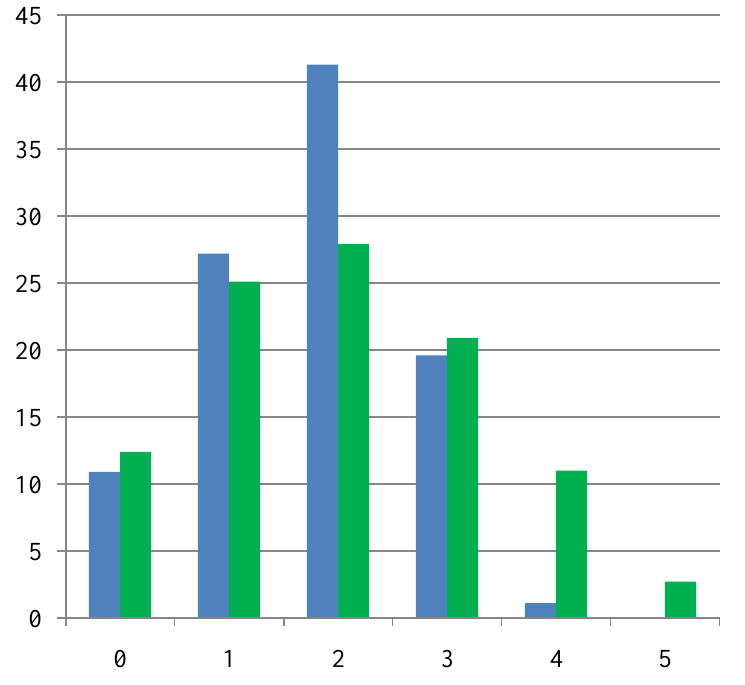
Figure 2. Benefit from the program